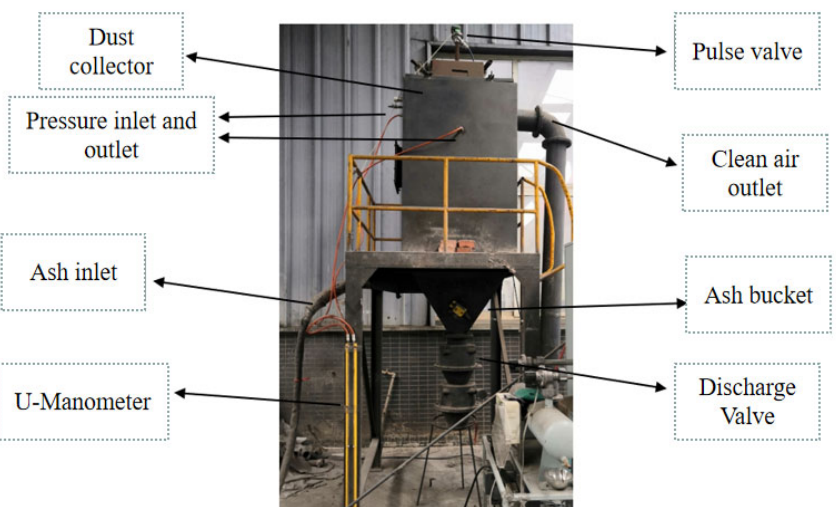
Figure 6. Industrial dust experiment platform.